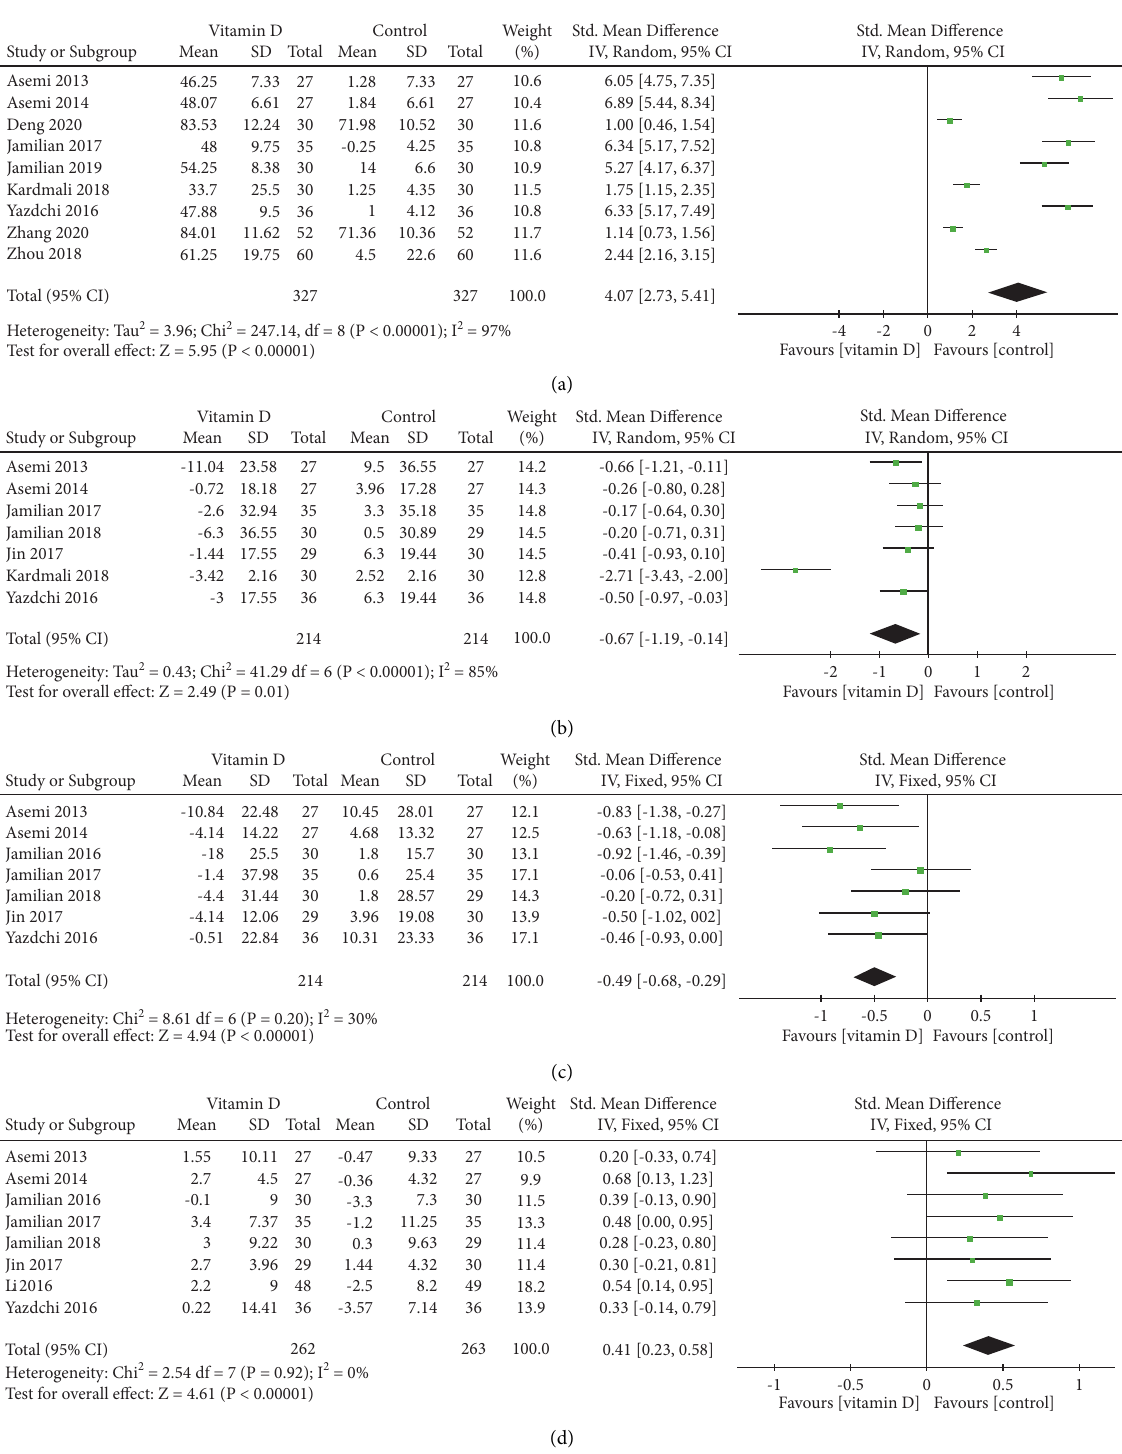
Figure 2: Forest plots for (a) the serum 25(OH)D level, (b) the serum TC level, (c) the serum LDL level, and (d) the serum HDL